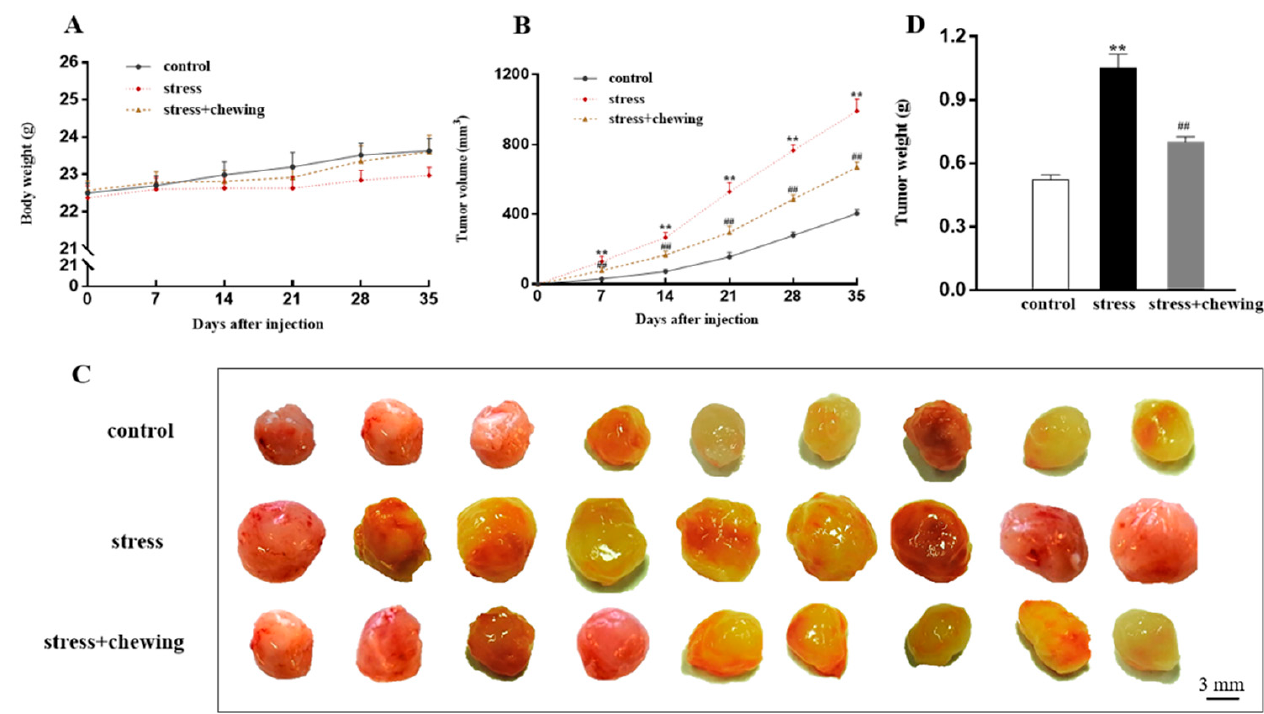
Figure 1. Chewing behavior during psychological stress inhibited tumor growth. ( A ) Mouse body weight growth curves. ( B ) Tumor growth curves. ( C ) Representative photograph of tumors after dissection. ( D ) Tumor weight on day 35 after inoculation. (** p < 0.01 vs. control group, ## p < 0.01 vs. stress group, n = 9/group). All data are expressed as mean ± SEM.